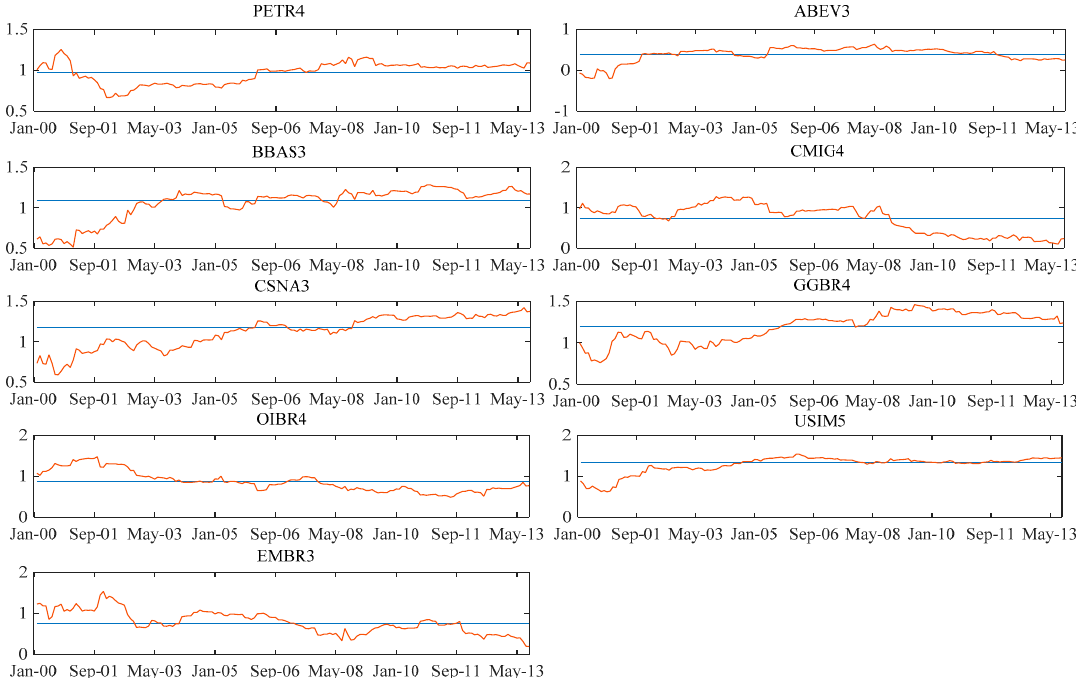
Figure A1. β (red line) versus long-term B (blue line): Significant A&F models.